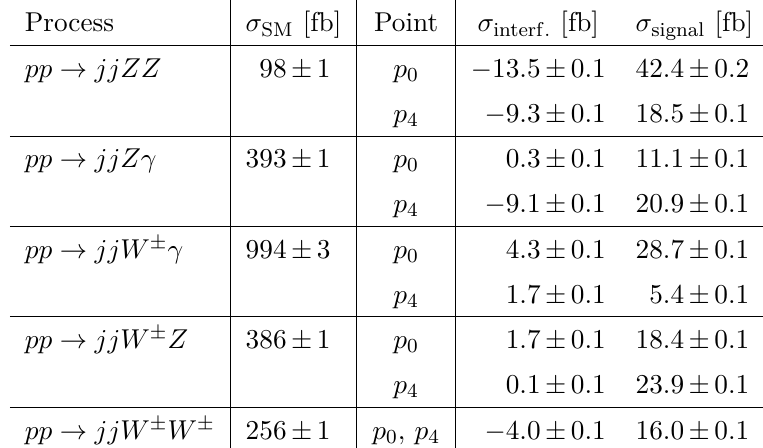
√ s = 13 TeV , before